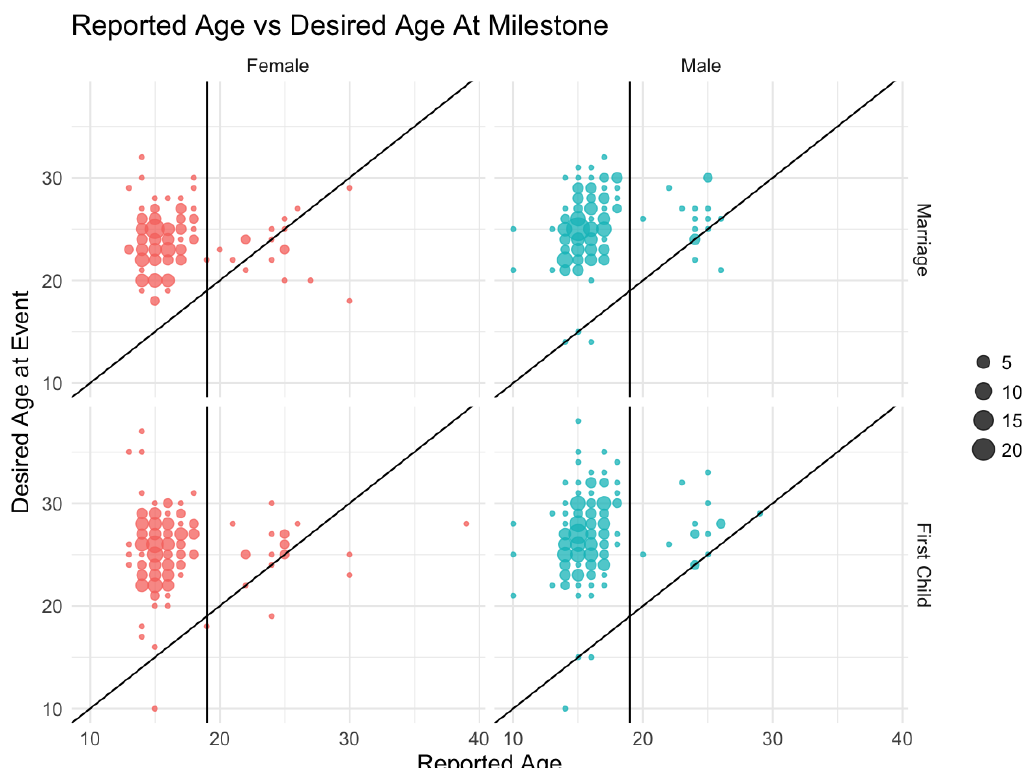
Figure 2. In-game reported age compared to age of milestones reported in the game, including line of equivalence (diagonal) and line marking age 19